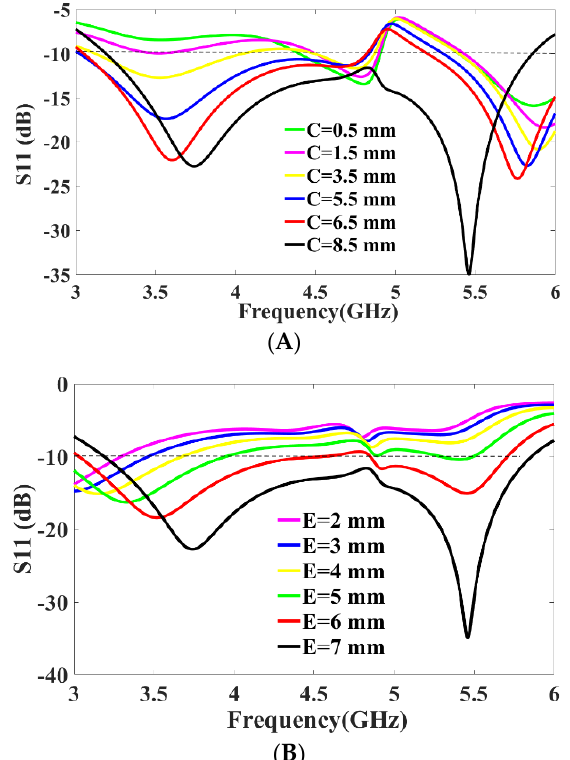
Figure 9. Parametric Analysis: ( A ) S 11 [dB] vs. Frequency [GHz] for slot C parameter values, ( B ) S 11 [dB] vs. Frequency [GHz] for slot E parameter values.